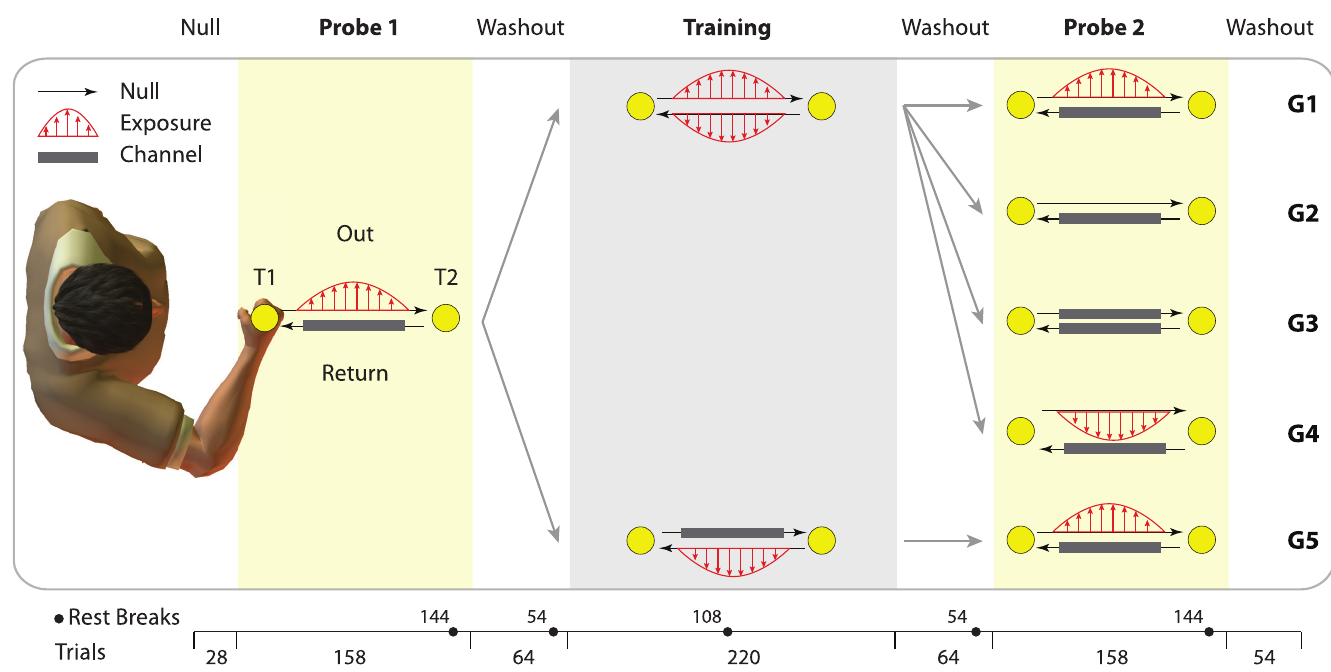
Fig 1. Experimental paradigm. Subjects made Out and Return reaching movements between two targets (T1 and T2), while in each movement direction, one of three trial types (dynamics) was introduced: exposure to a velocity-dependent force field, channel trials, and null trials (see legend). The experiment consisted of three main phases: Probe1, Training and Probe2. In Probe1, all groups experienced a force field on the Out movement, and channels on the Return. This allowed us to measure the a priori coupling (transfer of learning) between the Out and Return movements. For the Training phase, subjects in G1 to G4 experienced exposure in both Out and Return movements concurrently, whereas for G5, subjects only experienced force field for Return movements. This was to test the effect of concurrent versus successive exposure on the coupling between Out and Return movements. The five groups further differed in Probe2 as illustrated. Channel trials were interspersed in all phases. Each phase was followed by a block of null trials (the “washout”). The number of trials in each phase is shown at the bottom of the figure. Subjects received multiple rest breaks during the experiment, indicated by the black circles (the numbers next to each circle indicates the trial number, withing the given block, after which the rest break was introduced). The paradigm was counter-balanced across subjects within each group, both for the direction of the Out movement (T1 to T2, or T2 to T1) and the force field direction (clockwise or